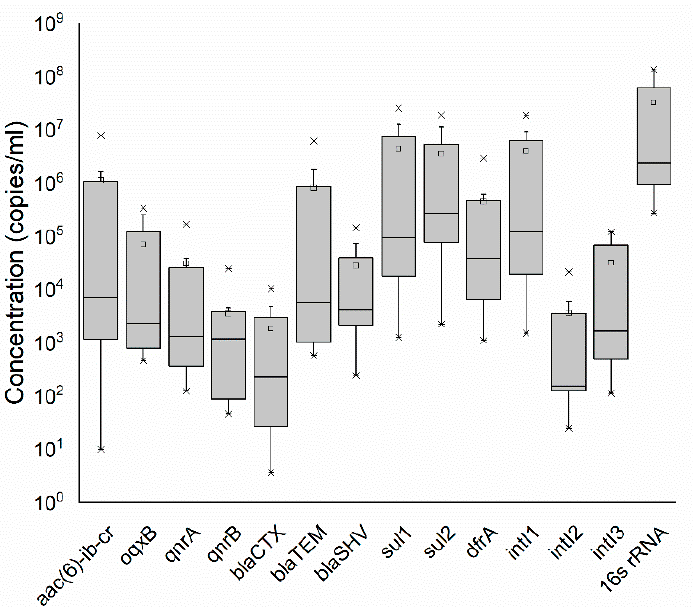
Figure 1. Concentrations (copies/mL) of the target ARGs, integrons, and 16S rRNA gene in the surface water samples of the Saigon River at upstream and downstream locations of Ho Chi Minh City. The lower and upper “ × ” symbols in each box indicate the 1% and 99% percentiles of data points. The squares in the boxes indicate the mean values of the data points.